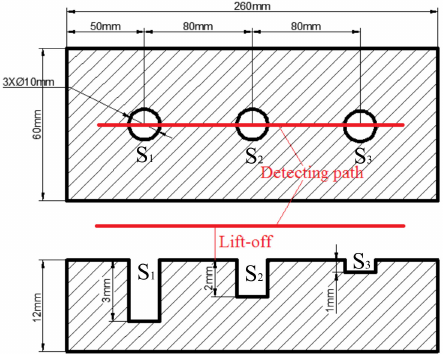
Figure 8. Schematic diagram of a 12 mm thick fiberglass board containing flat bottomed holes of surface depth (from left to right) 3 mm, 2 mm and 1 mm.